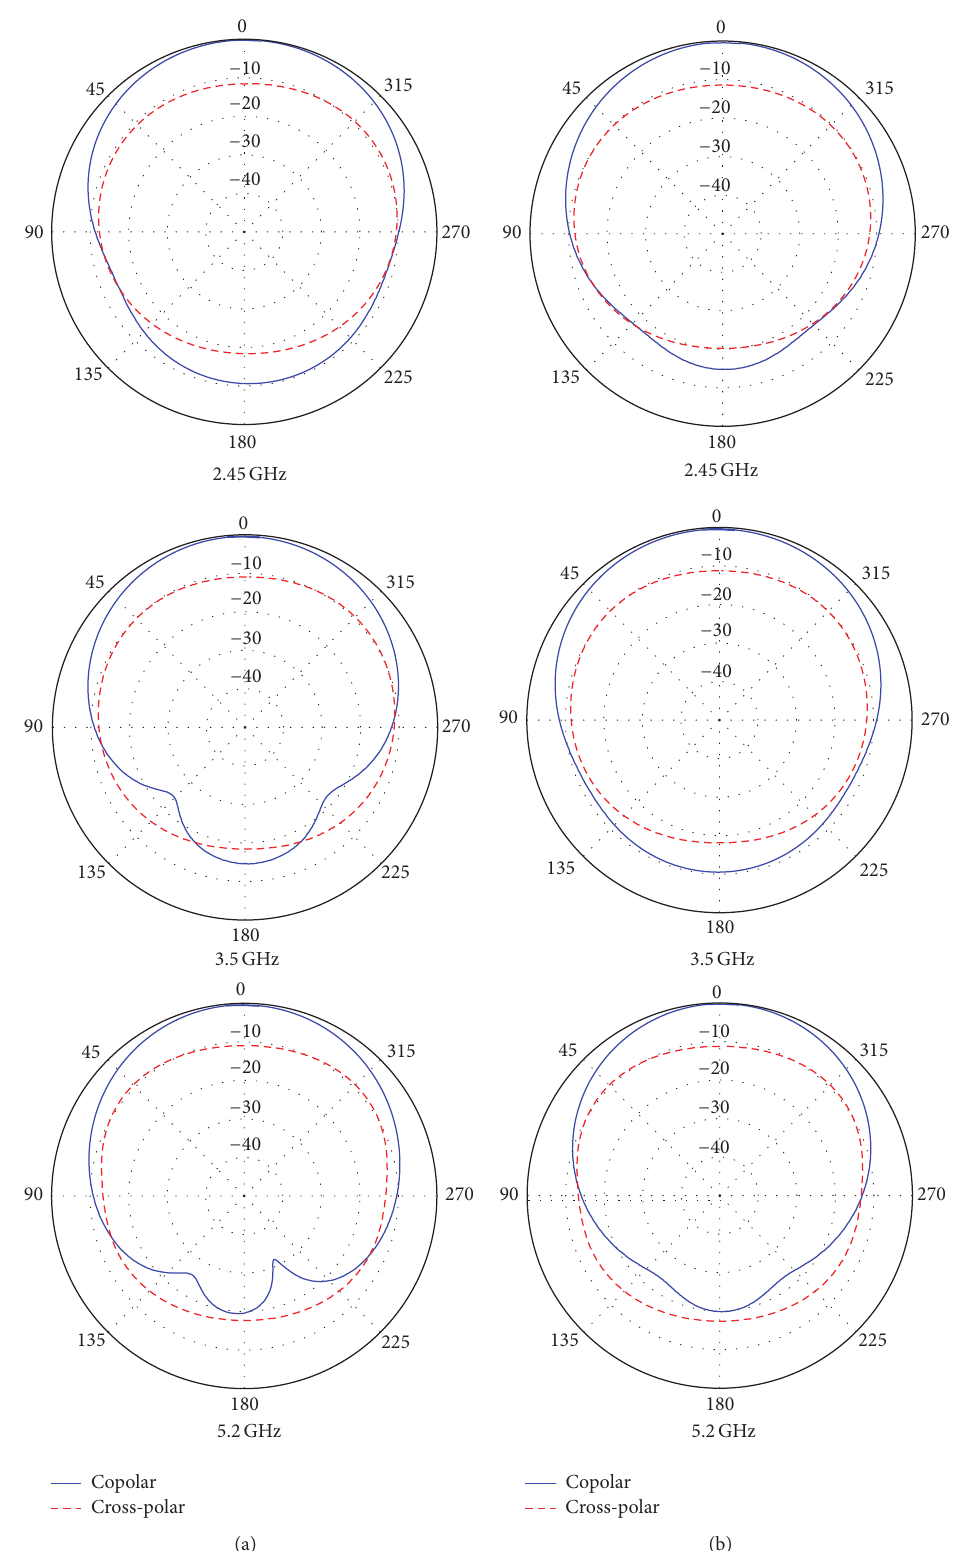
Figure 5: (a) 𝐸 -Plane and (b) 𝐻 -Plane radiation pattern of the designed antenna shown in Figure